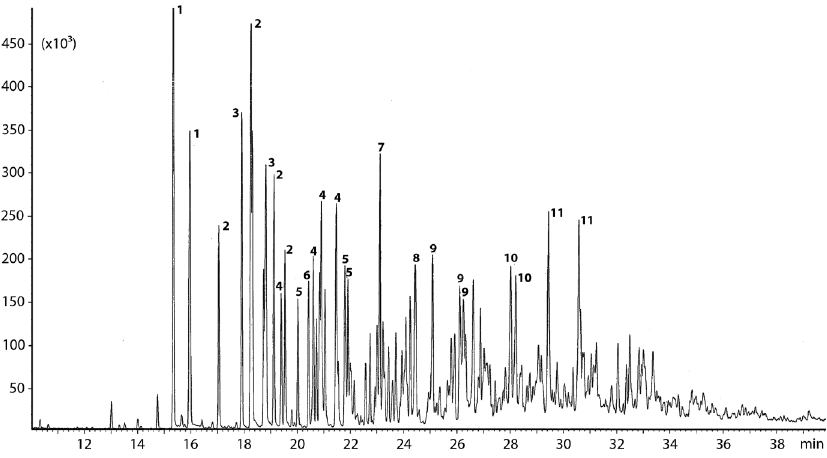
Fig. 3. A GC-MS chromatogram of the acidic sub-fraction of the middle distillate.